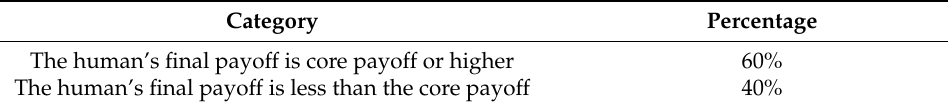
Table 3. Human final payoff compared to the expected core